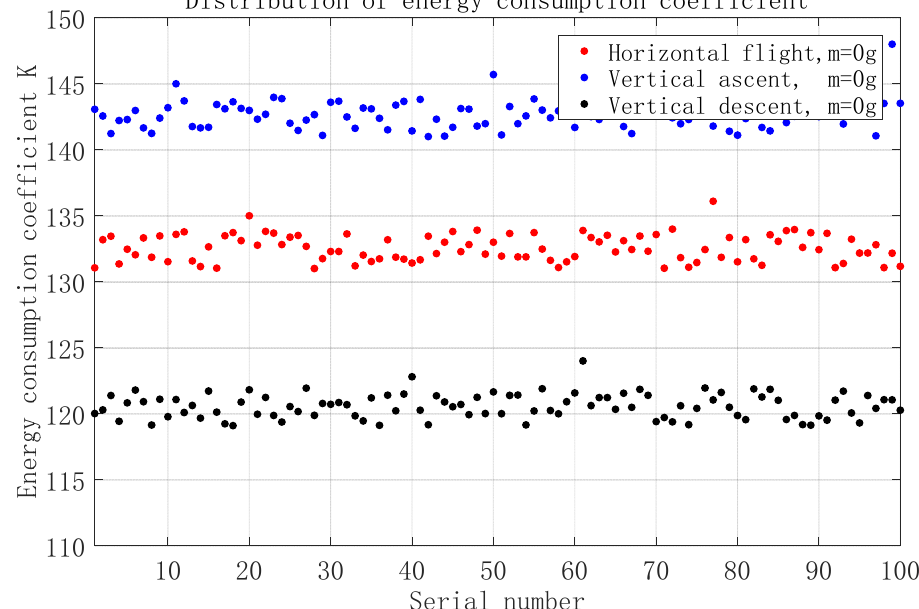
Figure 3. Distribution of energy consumption coefficient under different flight modes.